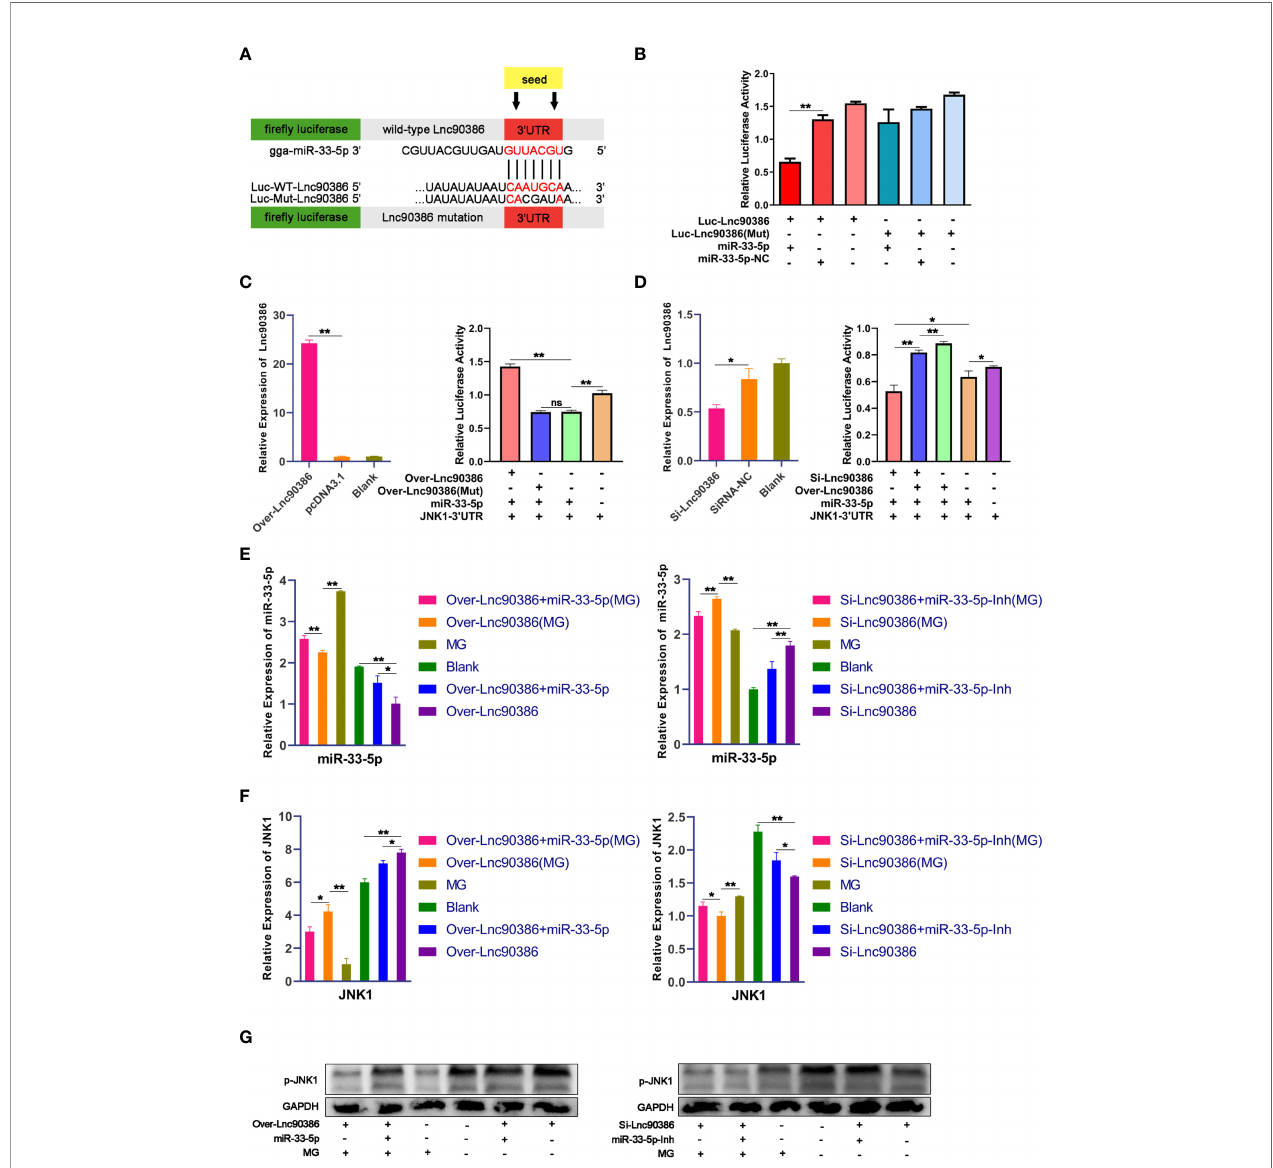
FIGURE 8 | Competitive binding between Lnc90386 and JNK1 for miR-33-5p. (A) psiCHECK-2 dual-luciferase reporter vector containing (wild-type or mutant) Lnc90386; (B) DF-1 cells were co-transfected with Luc- Lnc90386 (wild-type or mutant) and the indicated RNA activity through a dual-luciferase glow assay; (C) DF-1 cells were co- transfected with Over-Lnc90386 (wild-type or mutant), Luc-JNK1 3 ′ UTR and the indicated RNA. At 24h post-transfection. The expression levels of Lnc90386 after treatment with Over- Lnc90386 were detected by qPCR. The cells were assayed for both fi re fl y and renilla activity through a dual-luciferase glow assay; (D) DF-1 cells were co- transfected with Si-Lnc90386, Luc-JNK1 3 ′ UTR and the indicated RNA. At 24h post-transfection. The expression levels of Lnc90386 after treatment with Si-Lnc90386 were detected by qPCR. The cells were assayed for both fi re fl y and renilla activity through a dual-luciferase glow assay; (E) The mRNA of miR-33-5p after treatment with Over- Lnc90386/Si-Lnc90386. 5s-RNA were used as the internal control; (F) The mRNA of JNK1 after treatment with Over- Lnc90386/Si-Lnc90386; (G) The protein expression of JNK1 after treatment with Over- Lnc90386/Si-Lnc90386. GAPDH was used as the internal control. (* p < 0.05, ** p <